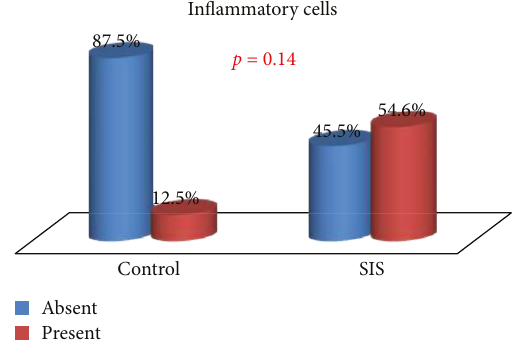
Figure 9: In fl ammatory cells: group comparison.